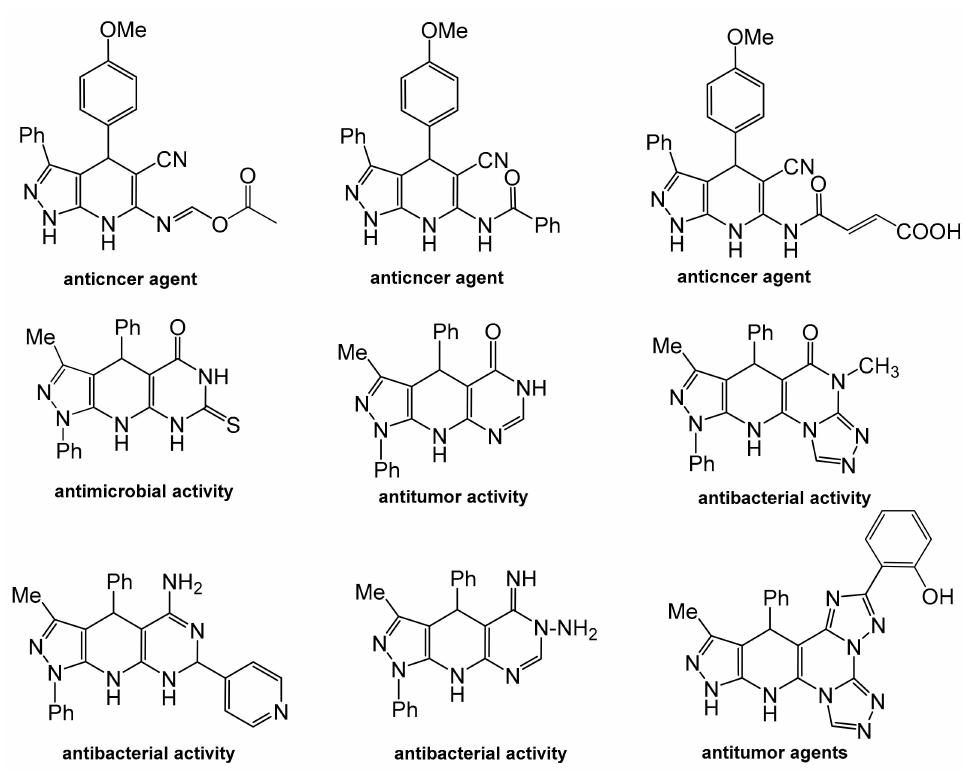
Figure 2. Pyrazolopyridines with reported antimicrobial, antibacterial and anticancer efficacies as well as DNA-binding